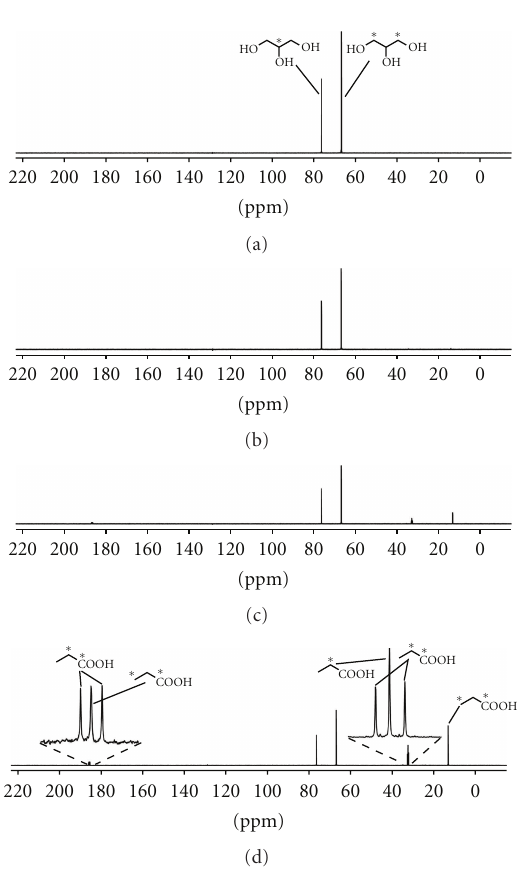
Figure 3: 13 C-NMR analysis of liquid cultures of Propionibacterium jensenii harvested after 0h (a), 24h (b), 48h (c), or 96h (d). A 1: 1 mixture of 13 C 1,3 -glycerol and 13 C 2 -glycerol was used as carbon source, ( ∗ = 13